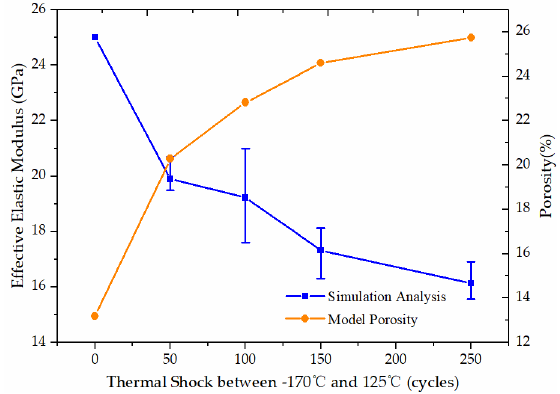
Figure 16. Changes in effective elastic modulus and porosity.